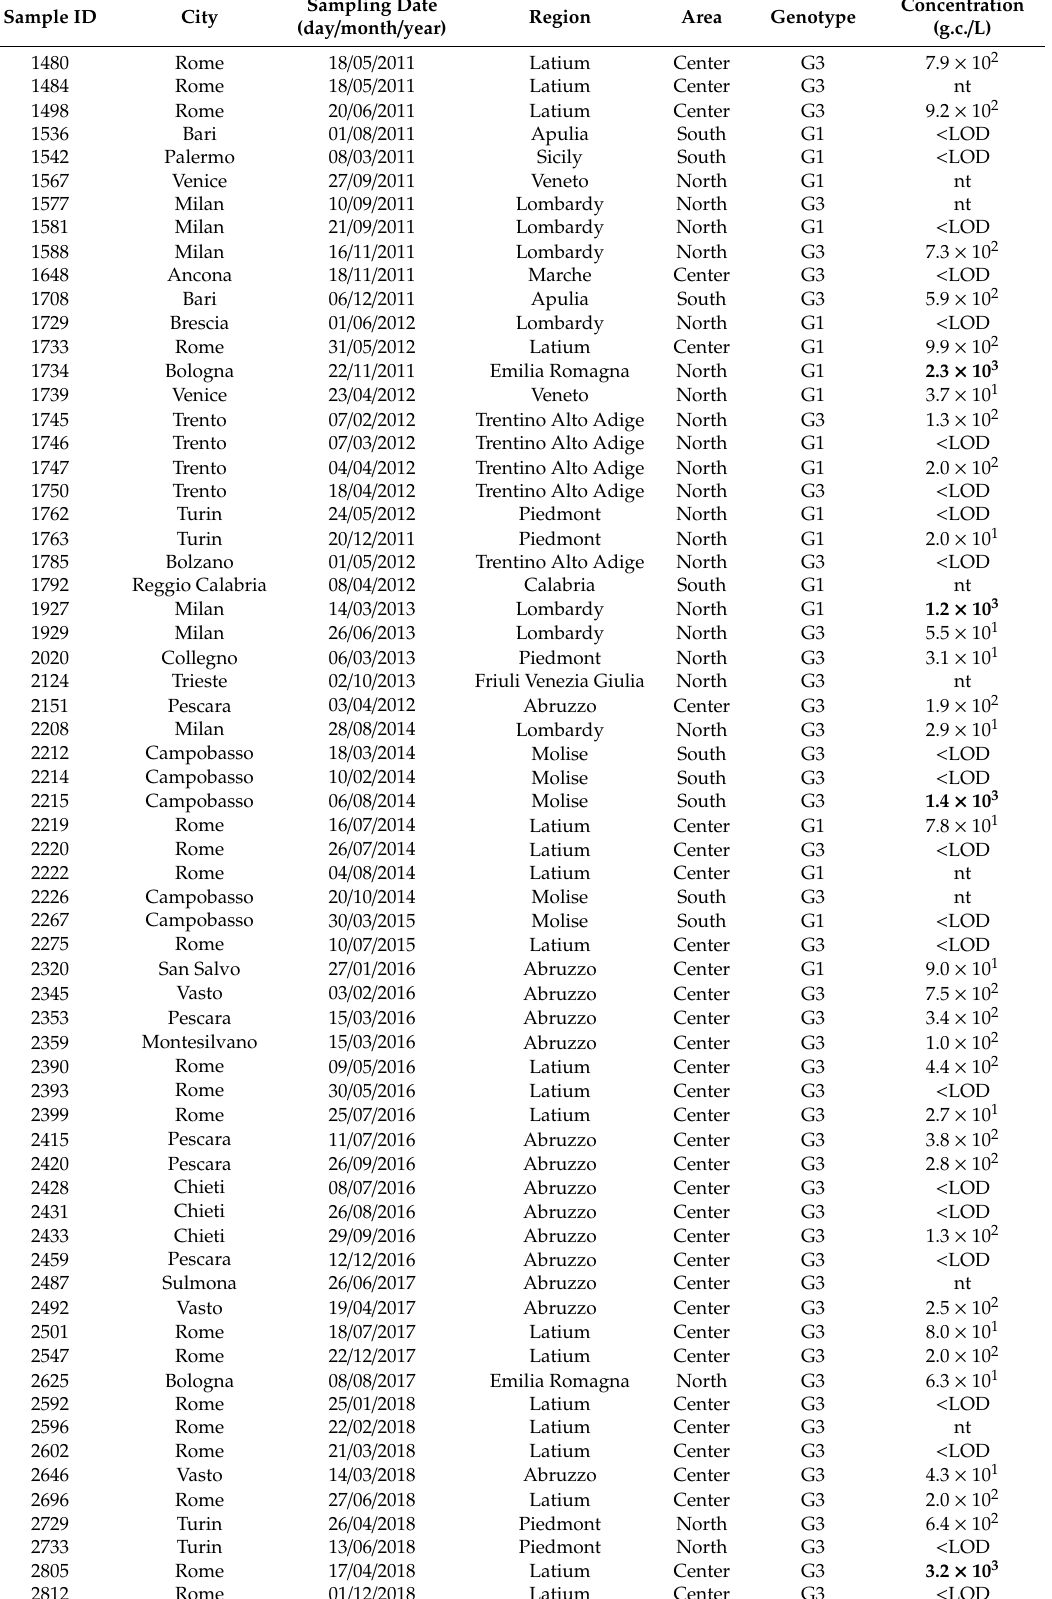
Table 2. Genotyping and HEV concentration in positive